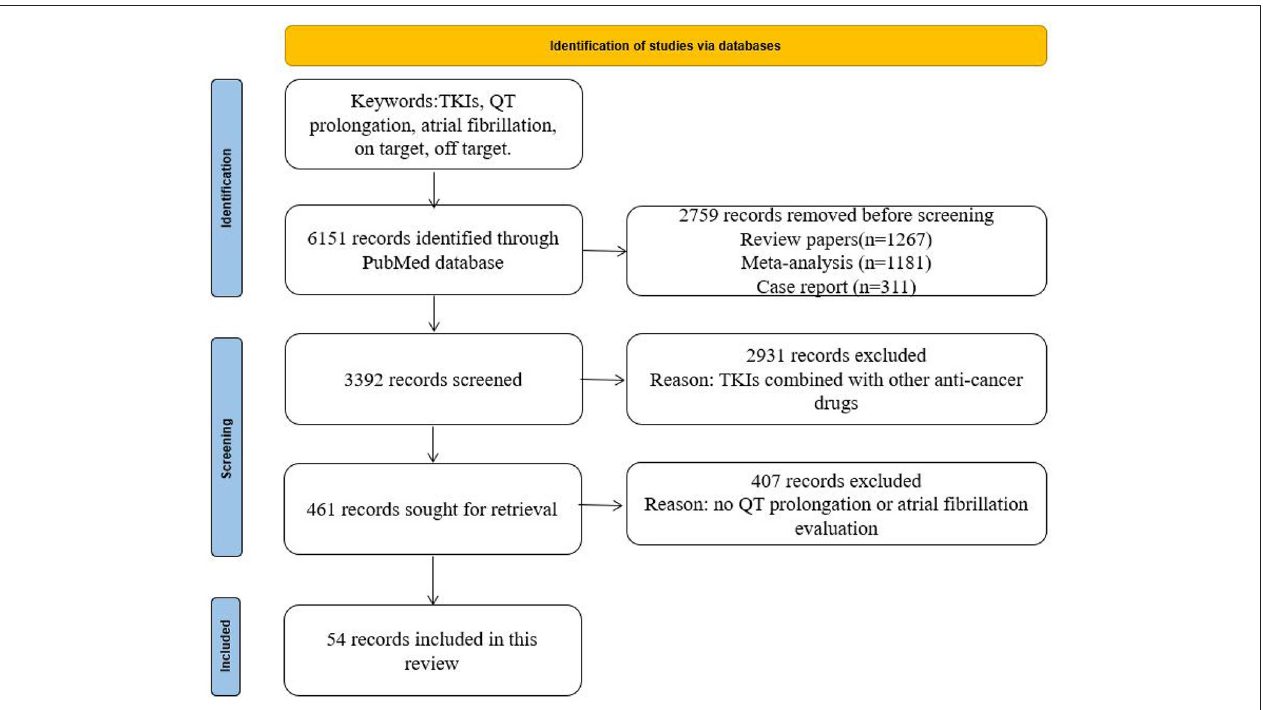
FIGURE 1 | Search strategy and selection